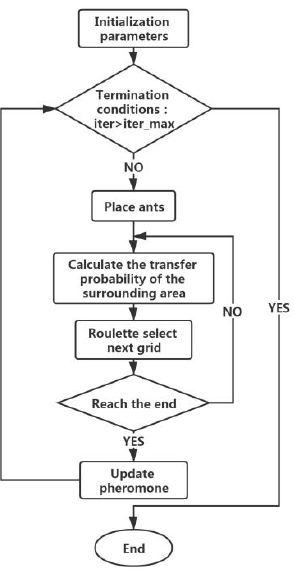
Figure 3. The technology route of ant colony